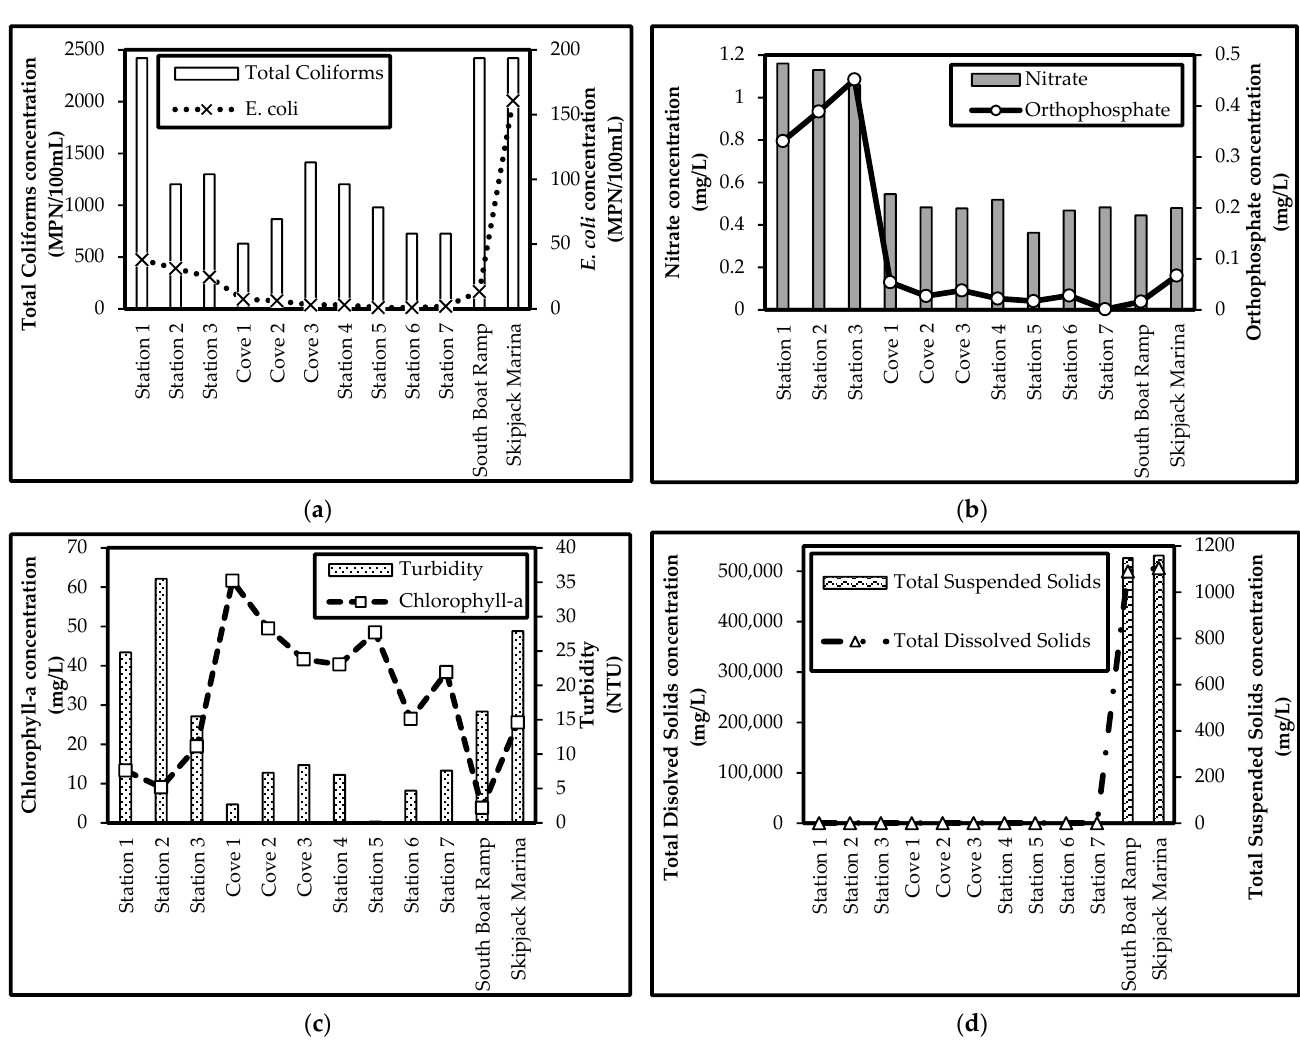
Figure 3. Concentration for each sample point at High Rock Lake during the sampling campaign for ( a ) Total coliforms and E. coli ; ( b ) Nitrate and orthophosphate; ( c ) Turbidity and Chlorophyll-a; ( d ) Total dissolved solids and total suspended solids.